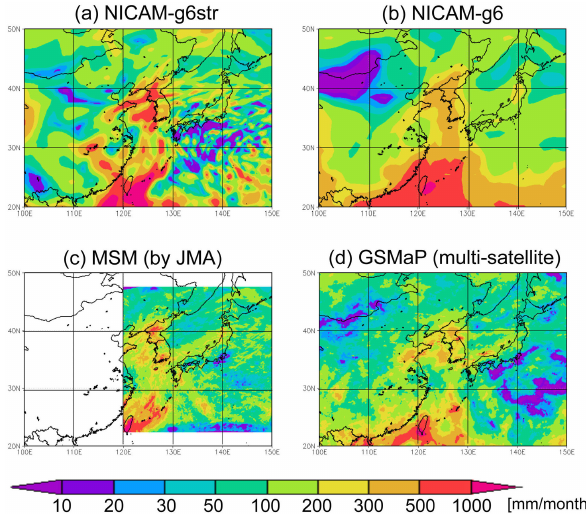
Figure 8. Horizontal distributions of precipitation in August aver- ages derived from (a) simulation by NICAM-g6str, (b) simulation by NICAM-g6, (c) reanalysis data from MSM by JMA and (d) re- analysis data from